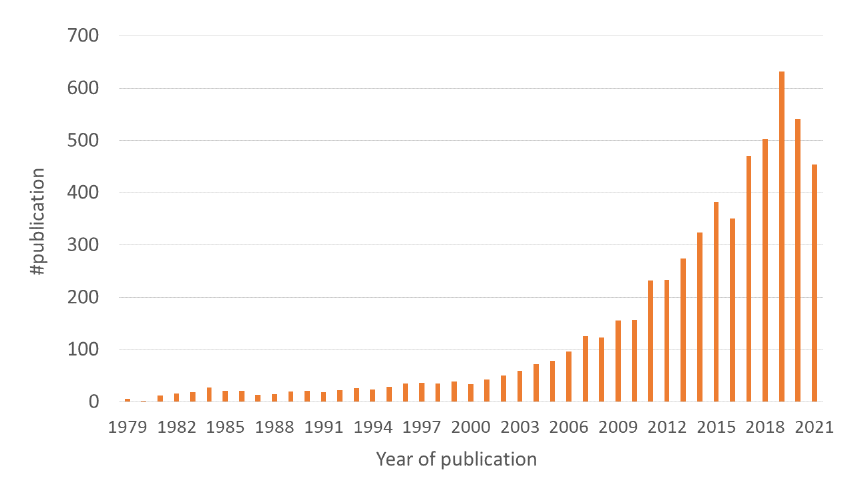
Figure 4. Increasing Interest in Considering OBs.